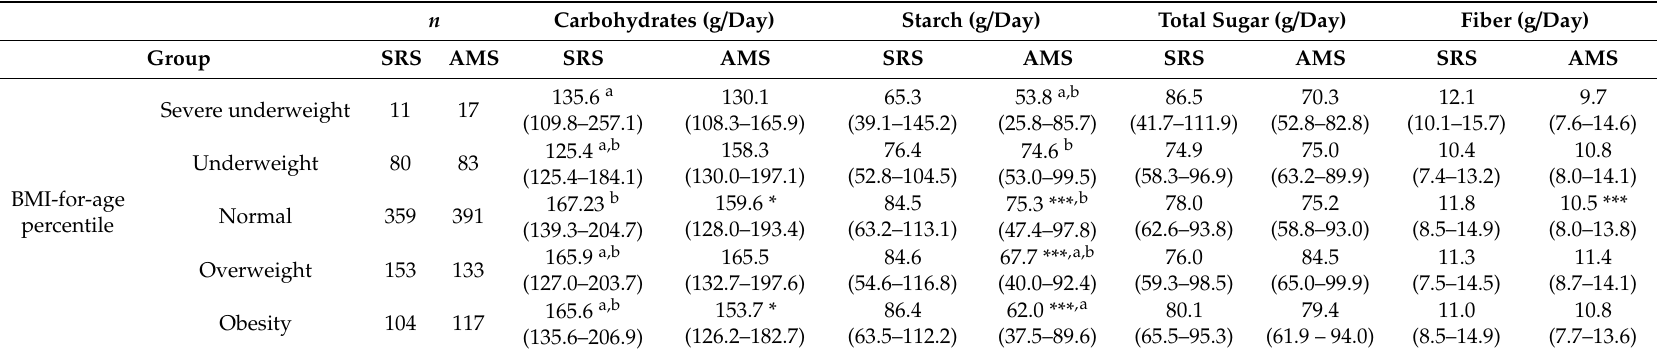
Table 6. Total carbohydrates, starch, total sugar, and fiber intake in relation to body composition amongst the Spanish Pediatric Population (EsNuPI) study in the Spanish Reference Cohort (SRS) and the Adapted Milk Consumers Cohort (AMS).